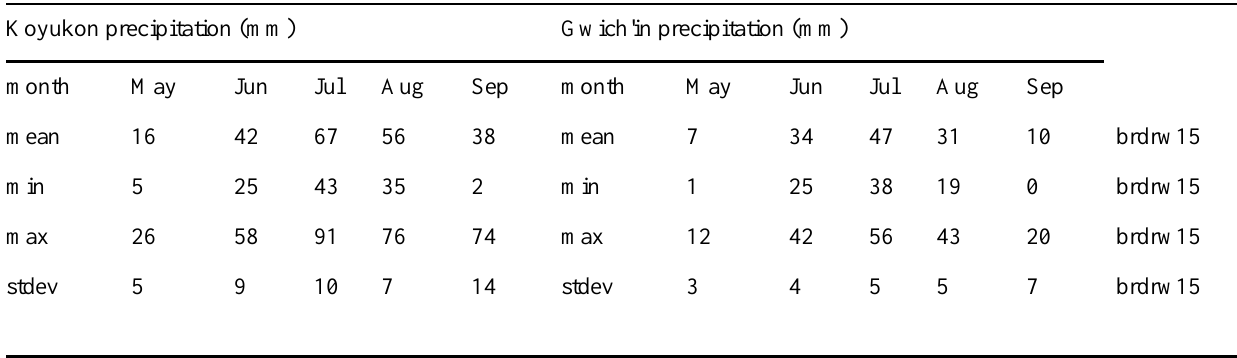
Table 3. Mean monthly precipitation (1901-1930) comparison of Koyukon and Gwich’in territories in